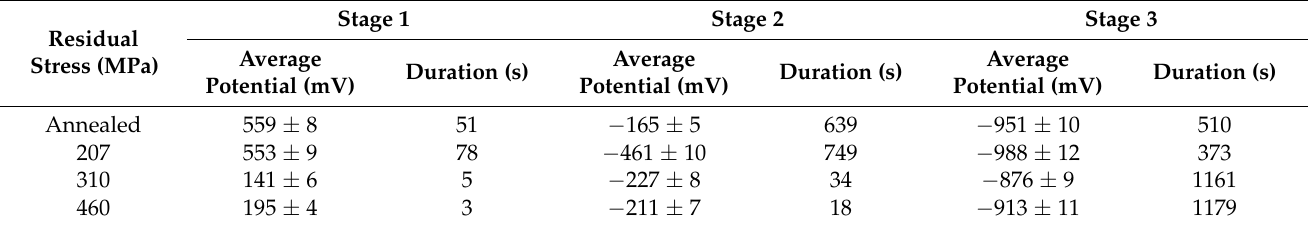
Table 3. Potential and duration of different stages during galvanostatic measurements for various RS magnitudes.